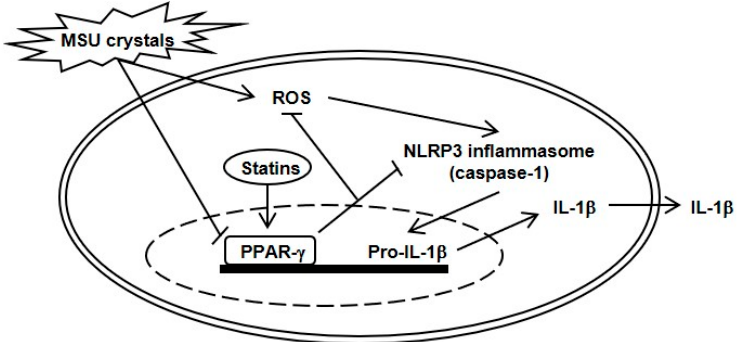
Figure 5. Schematic presentation for the role of statins in MSU crystal-induced NLRP3 inflammasome activation via PPAR- γ . In the process of MSU crystal-induced NLRP3 inflammasome activation and IL-1 β production, stimulation with MSU crystals induces suppression of PPAR- γ activity and production. In contrast, THP-1 cells incubated with statins stimulate PPAR- γ activity and production, and then subsequently block ROS generation and NLRP3 inflammasome activation through deactivation of caspase-1. PPAR- γ eventually acts as an inhibitory transcriptional nuclear regulator of uric acid-induced in fl ammation.